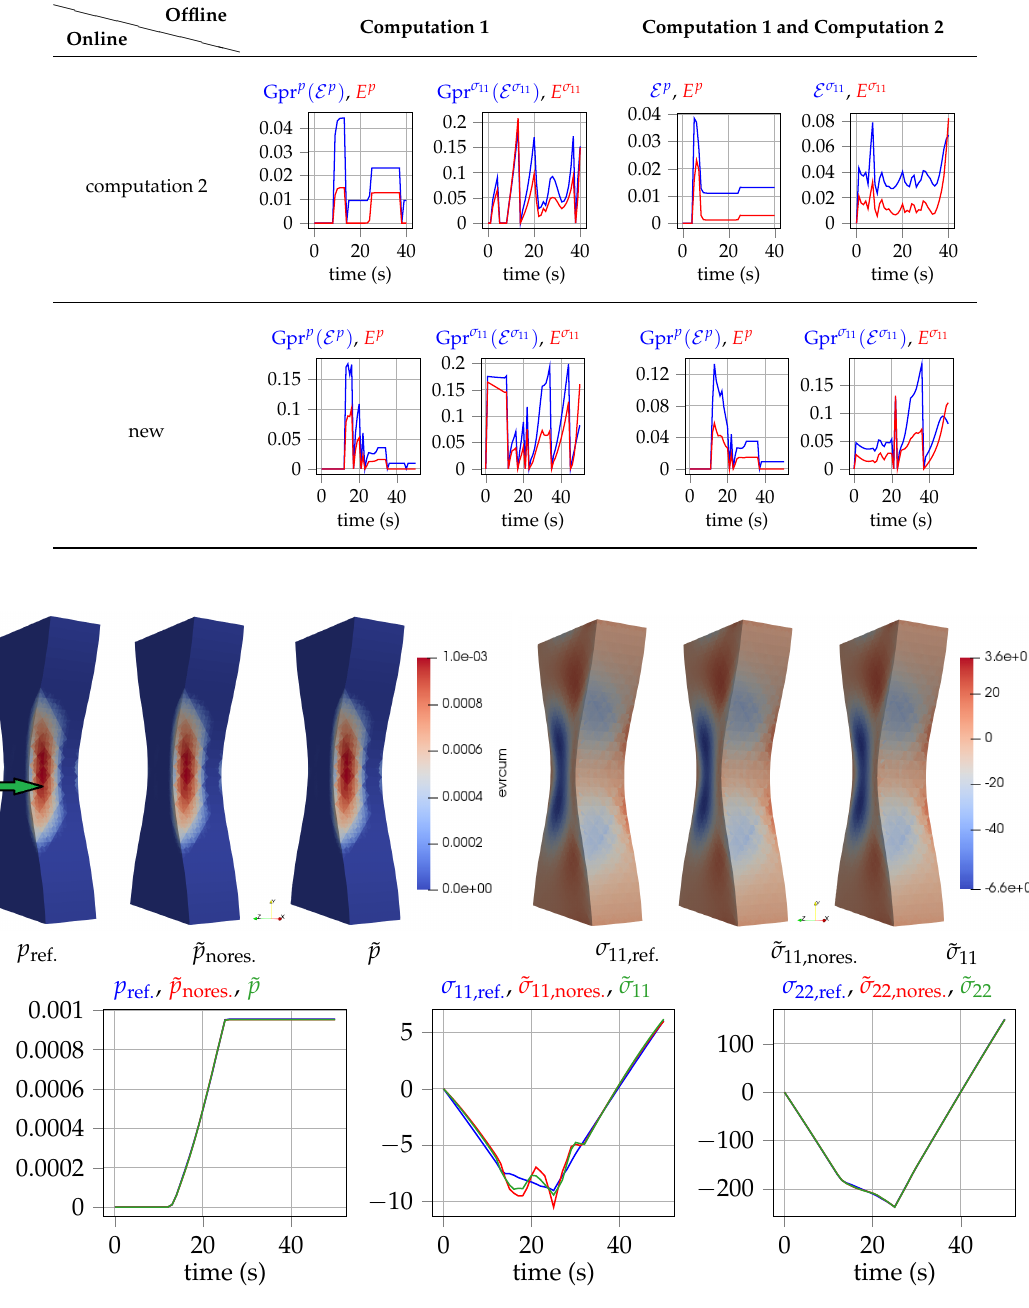
Figure 8. Offline variability: computation 1 and computation 2; online variability: computation 1. ( top ) Representation of dual fields for the reference high-fidelity (HF) prediction of the online variability, the reduced order model (ROM) without enrichment, and the ROM with enrichment (( left ) p at t = 50 s and ( right ) σ 11 at t = 25 s). ( bottom ) Comparison of p , σ 11 and σ 22 at the point identified by the green arrow on the top-left